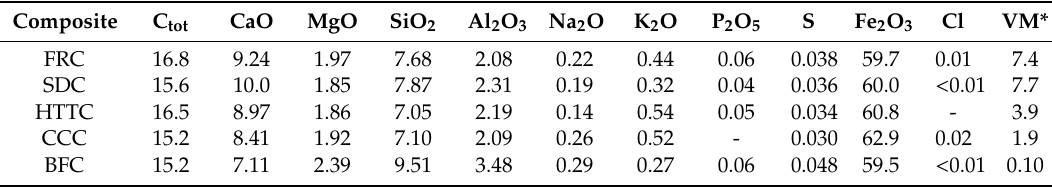
Table 6. Chemical composition of self-reducing composites, (wt